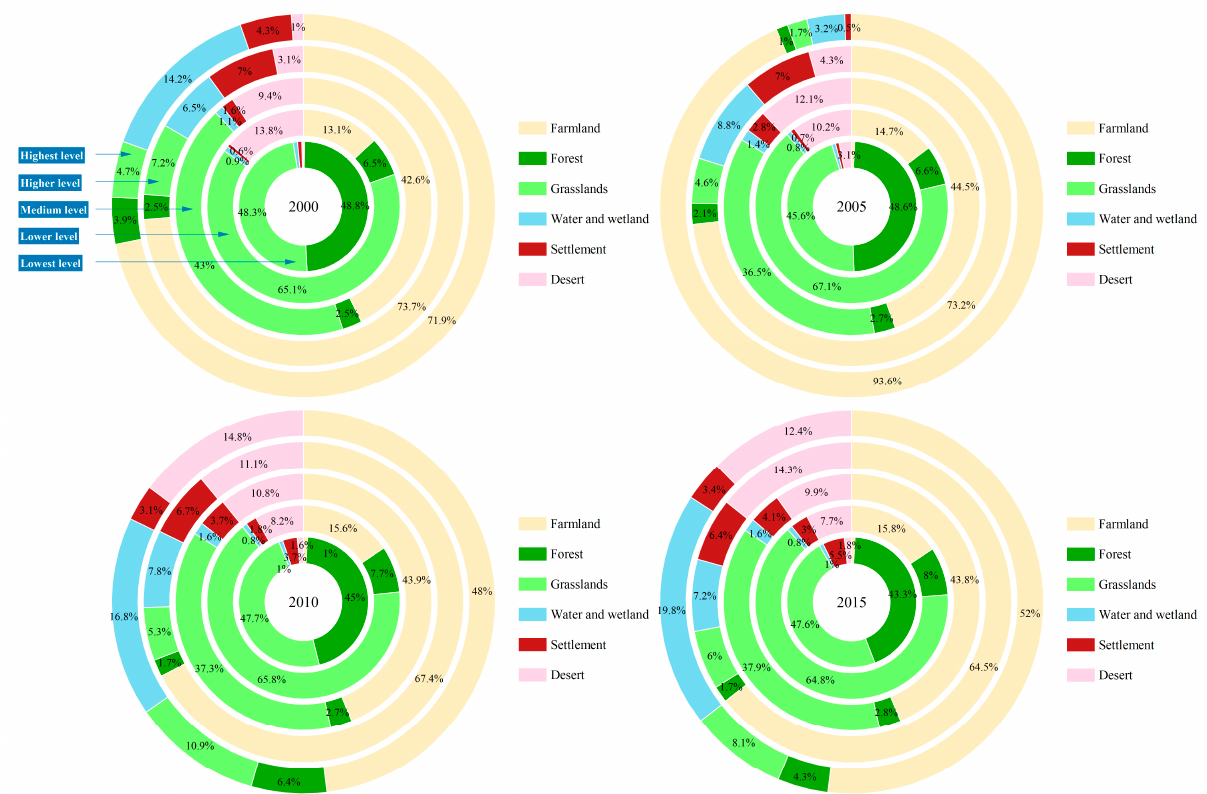
Figure 13. Ring diagram of LER contribution of each land use type in Ningxia from 2000 to 2015. From 2000 to 2015, the area proportion of forest and grasslands in each LER level remained basically unchanged each year, while farmland was still the main risk source of each LER level. For other ecosystem types, desert was mainly distributed in the lower and medium ecological landscape risk levels in 2000, and then the area proportion gradually expanded in the higher and highest LER levels, becoming one of the main sources of LER in Ningxia. In contrast to desert, the area proportion of settlement in the higher and high- est LER levels decreased, and the area proportion in the medium LER level, lower LER level, and lowest LER level increased. As the second largest source of LER in the highest